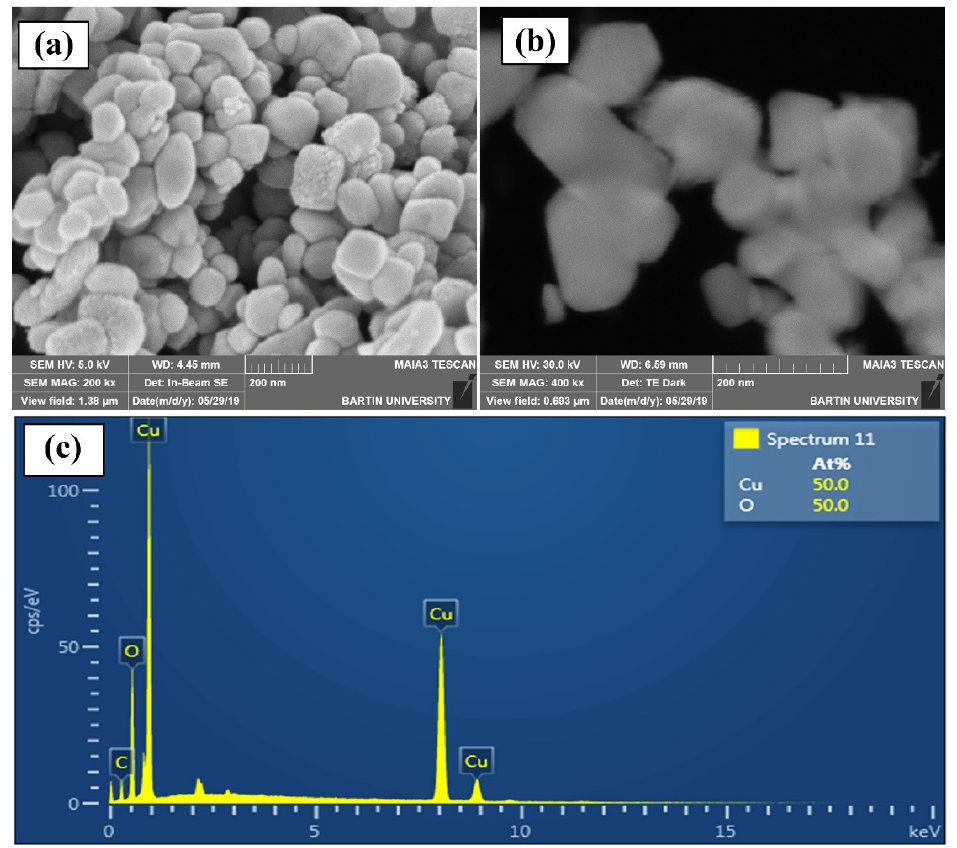
Figure 5. ( a ) SEM image of biosynthesized CuO NPs ( b ) Dark-field scanning transmission electron microscopy (DF-STEM) image ( c ) EDS image of CuO NPs.